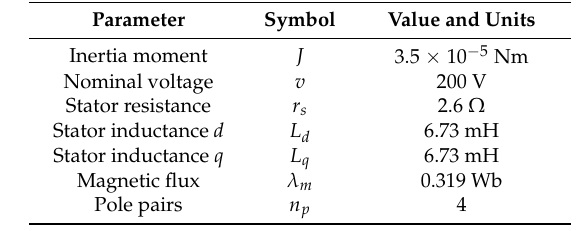
Table 1. Parameters of PMSM.